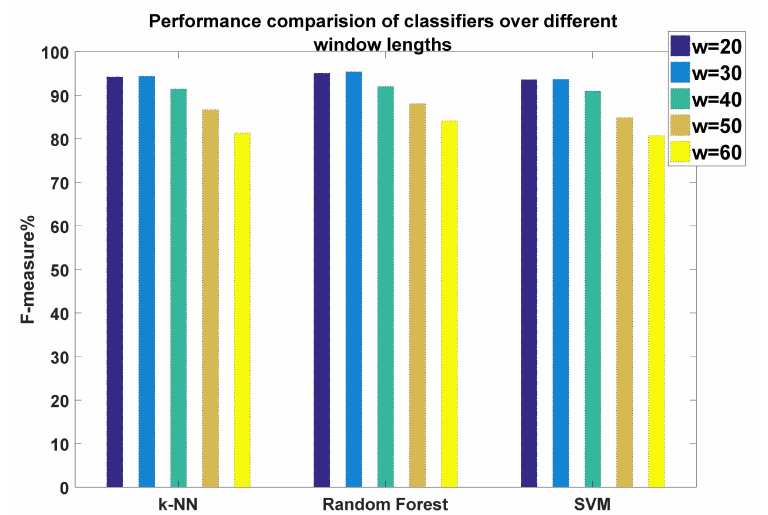
Figure 5. This figure demonstrates the impact of the window length over the classifiers’